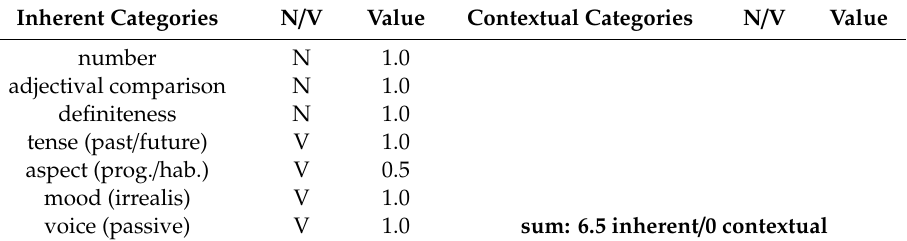
Table 8. The grammatical categories of